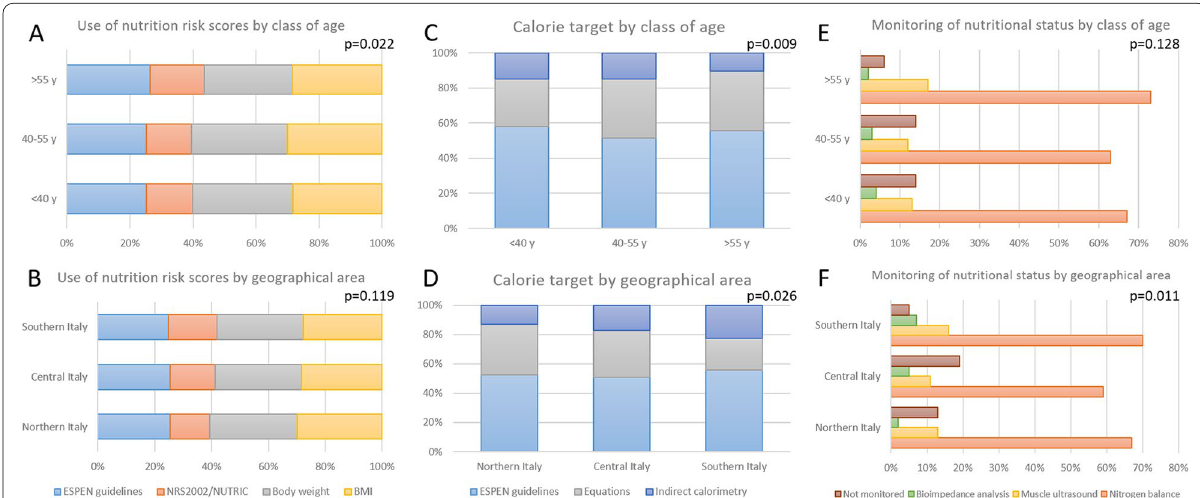
Fig. 1 Relationship between nutritional risk scores (left panel), nutritional requirements (middle panel), and monitoring of the metabolic intervention (right panel) and the class of age (upper) and geographical area (lower) of the